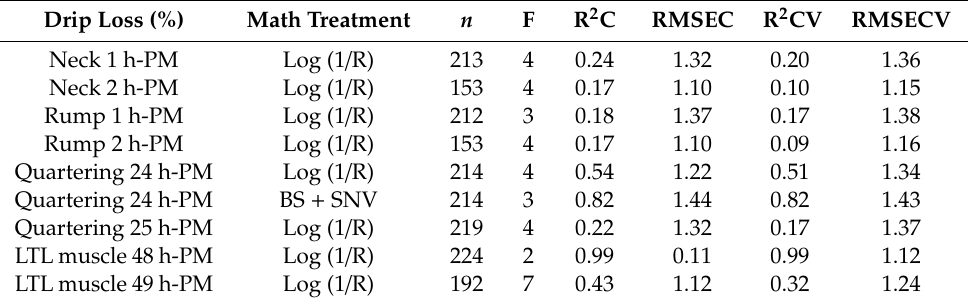
Table 3. Prediction of drip loss (%) of beef samples using Vis–NIR